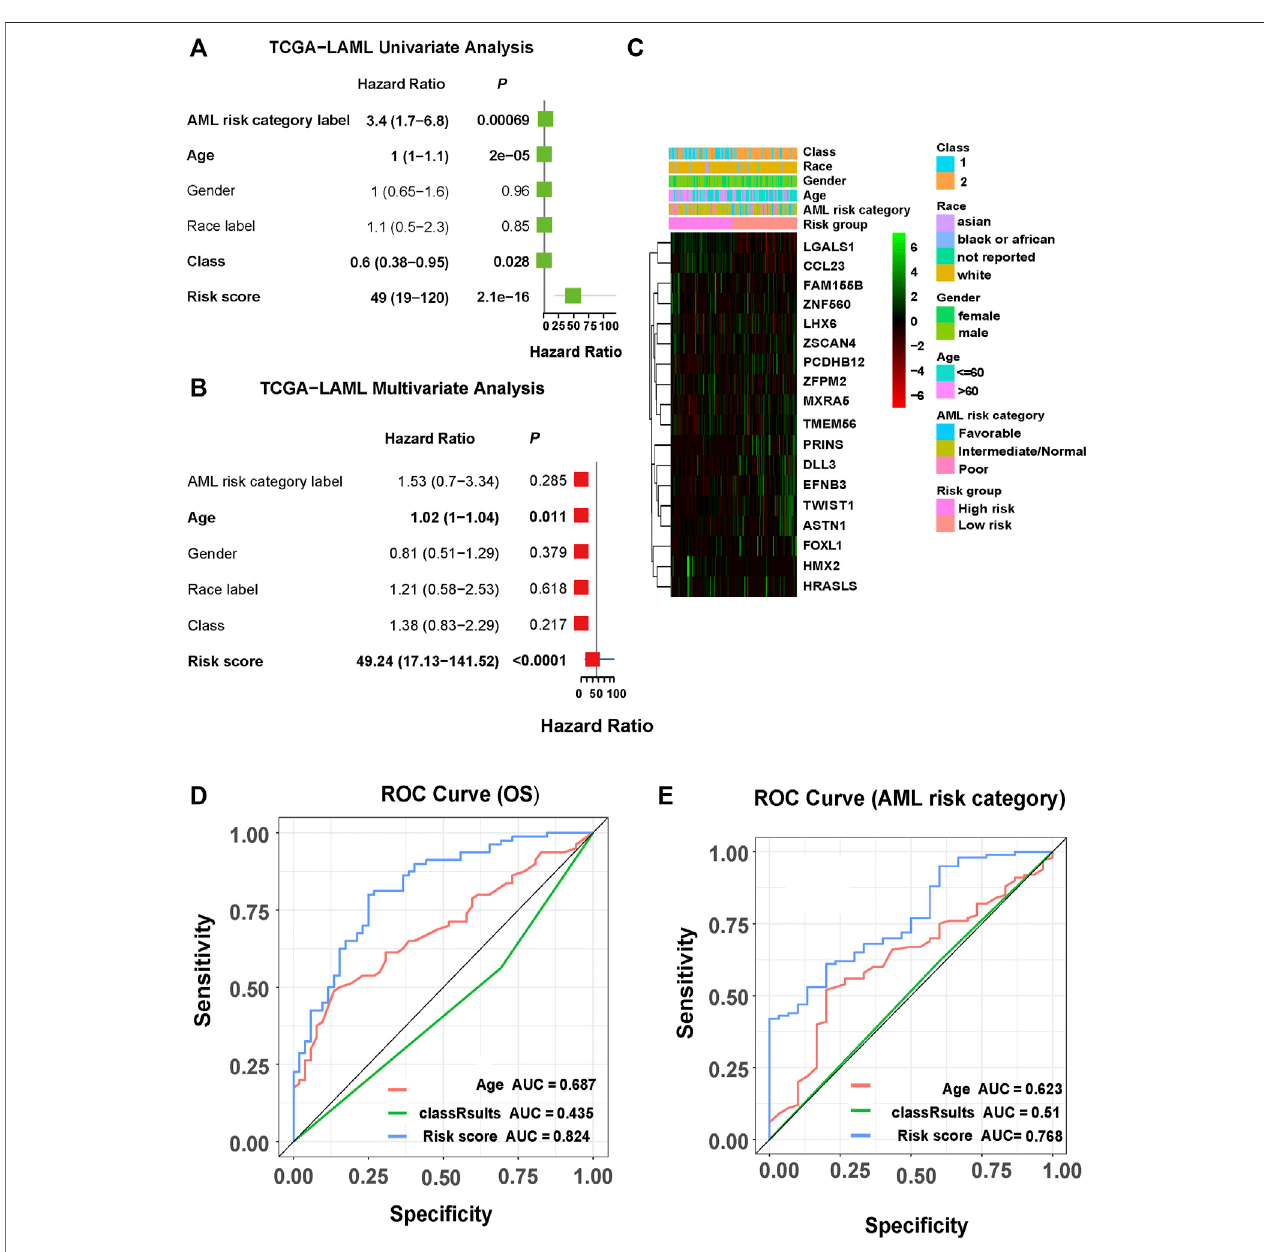
FIGURE 5 | Correlations among clinicopathological characteristics, risk score, and prognostic value in TCGA cohort. (A) Univariate analysis of clinicopathological factors and risk score. (B) Multivariate analysis of clinicopathological factors and risk score. (C) Heat map for the correlations between the 18-gene risk signature and clinicopathologicalfeatures. (D) ROCcurveshowingthepredictioneffectofriskscore,age,andclass1/2onsurvivalrate. (E) ROCcurveshowingthepredictiveeffectsof risk score, age, and class1/2 on AML risk grouping.